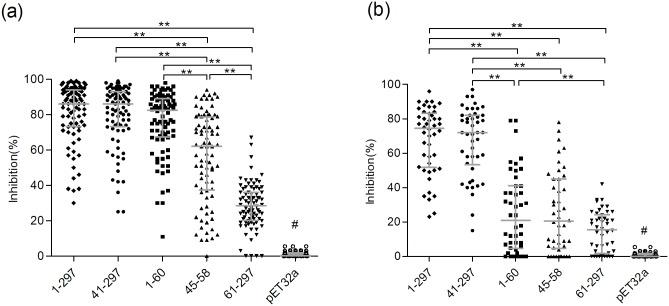
Comparison of the inhibition activities of five proteins in the Shanghai blood donors (a) and Shanxi individuals (b).The percentage of inhibition based on the competitive ELISA was plotted on the y-axis and six inhibitor proteins were plotted on the x-axis (CA16 VP1, VP141-297, VP11-60, VP145-58, VP161-297 and pET32a). Each symbol represents an individual sample, and the lines indicate Q1, Q2 and Q3 value of the group from the bottom to the top, respectively. Statistical significance was tested using the Nemenyi non-parametric test. * indicates p<0.05, ** indicates p<0.001. # represents p<0.05 comparing all other groups.